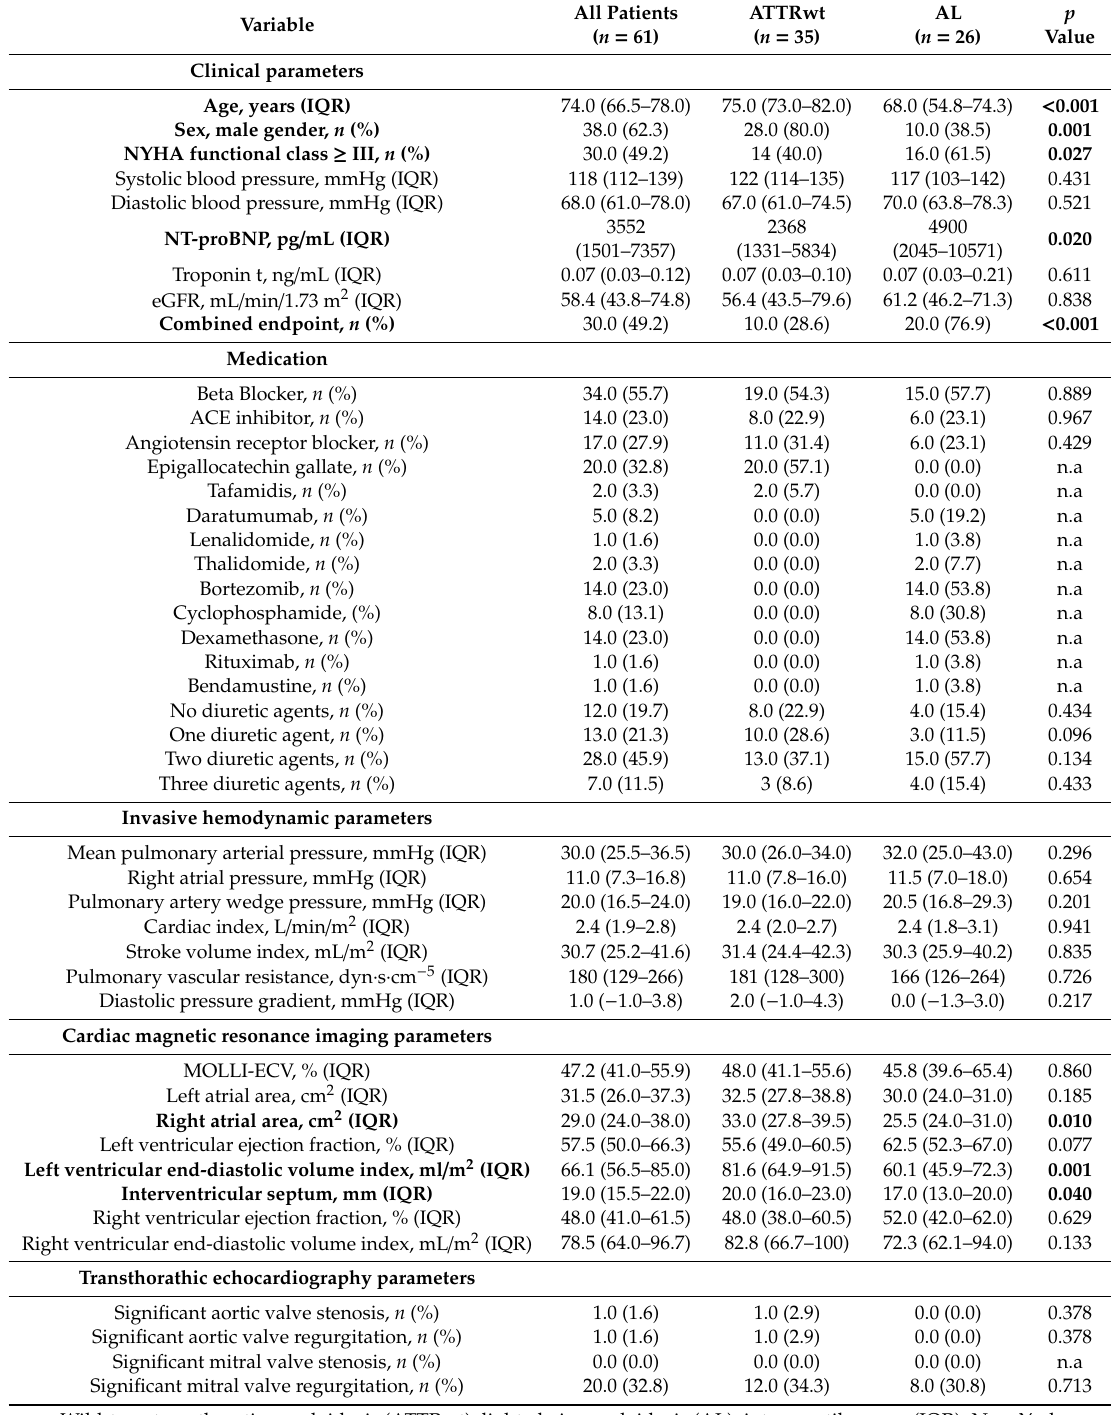
Table 1. Baseline